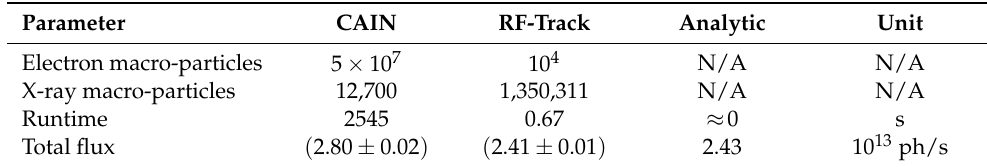
Table 3. Parameters used to compare the performance of RF-Track against CAIN. Values obtained from simulations of ThomX were compared with analytical estimates. The calculations were per- formed on the same PC for both RF-Track and CAIN. To obtain the standard error, both CAIN and RF-Track codes were run 10 times.